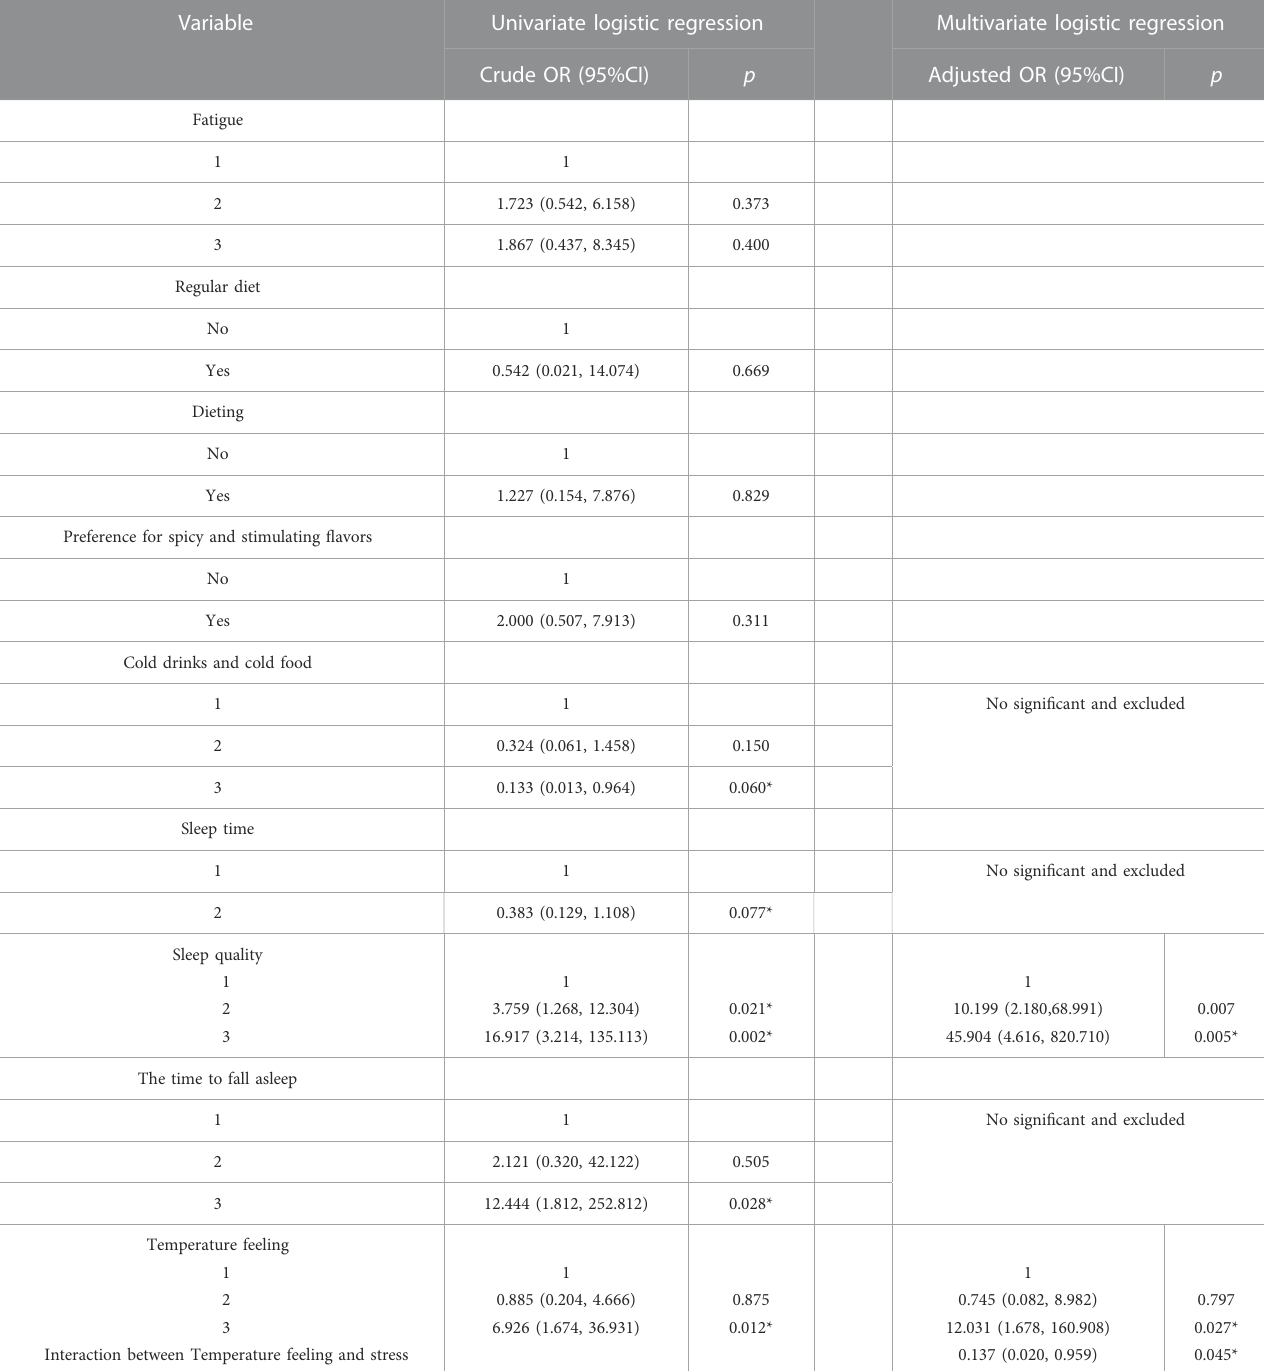
TABLE 3 ( Continued ) Logistic regression analysis to menstrual disorders and variable in two